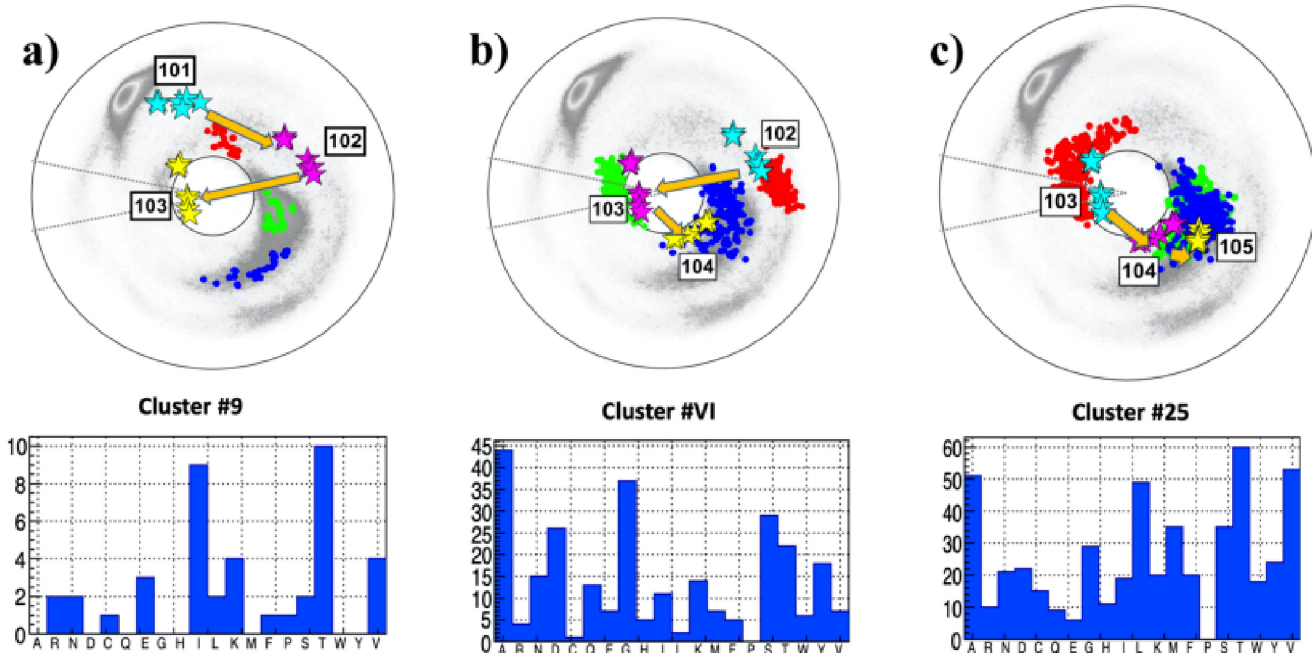
Fig 7. The ( κ i , τ i ) spectrum for i = 101 − 105; this engages sites 99 − 106 along the C α backbone. Panel a) The spectrum for P:(101, 102, 103), in the background of the best matching cluster #7 in [41]. The most common amino acids in the cluster is T, followed by I. Panel b) The spectrum for A:(102, 103, 104), in the background of the best matching cluster #26 in [41]. The most common amino acid in the cluster is A, followed by G. Panel c) The spectrum for F:(103, 104, 105), in the background of the best matching cluster #XI in [41]. The most common amino acid in the cluster are T and L, followed by A and V.